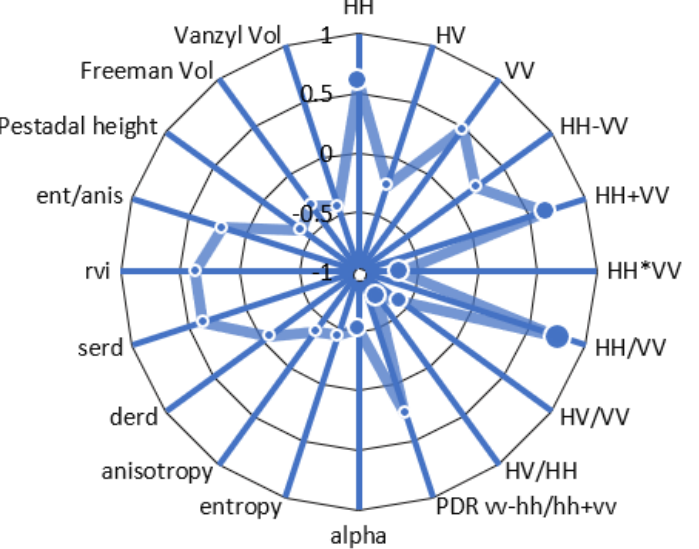
Figure 4. Pearson’s coefficient of correlation between grain yield and polarimetric parameters studied.